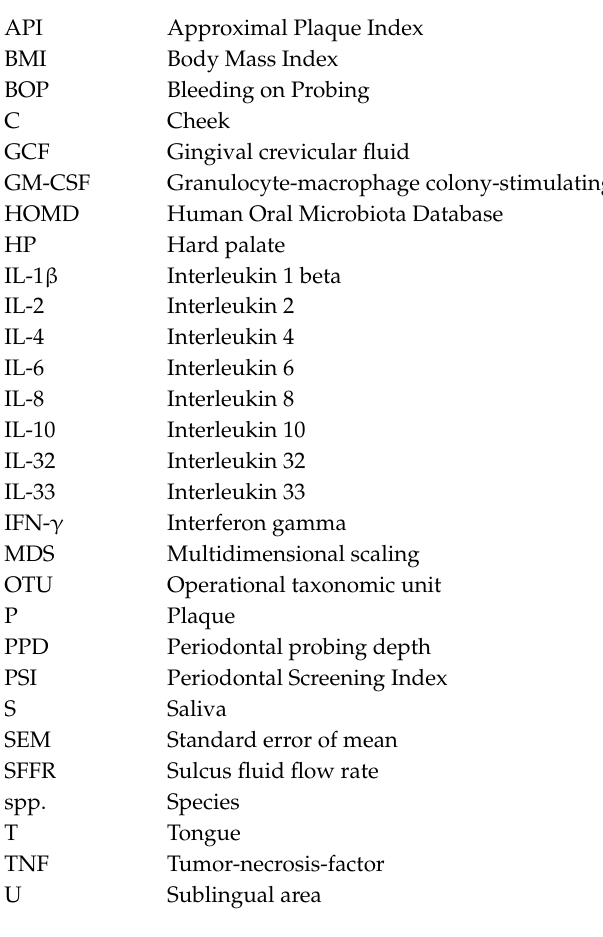
Figure S2: Histograms representing the concentrations of GM-CSF, IFN- γ , IL- 10, IL-1ß, IL-2, IL-4, IL-6, IL-8, TNF in defined oral niches, Table S1: Clinical parameters of the study